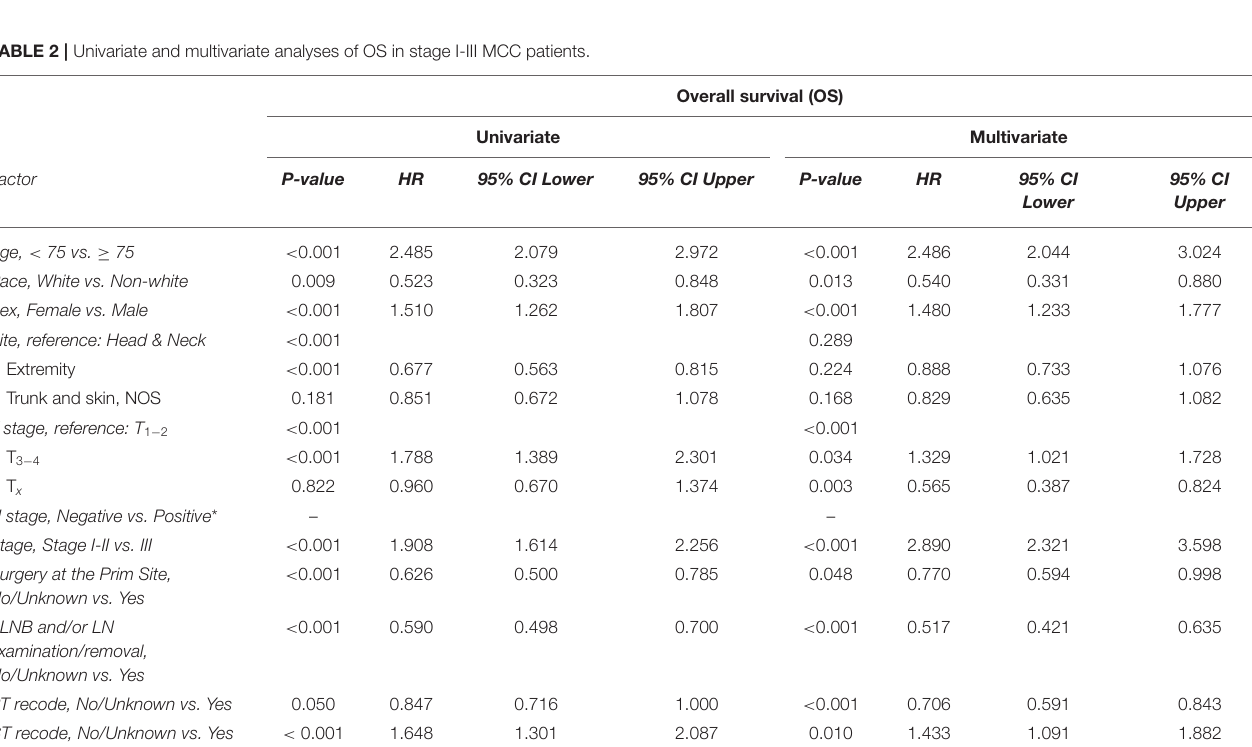
TABLE 2 | Univariate and multivariate analyses of OS in stage I-III MCC patients.